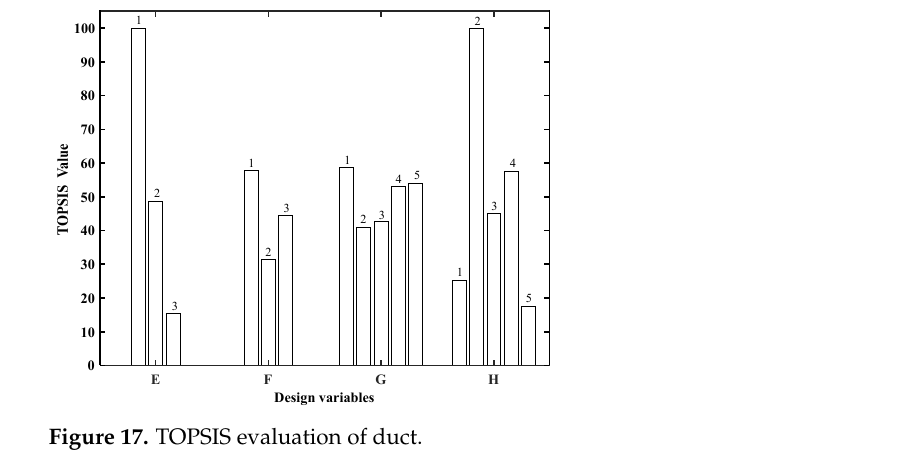
Table 10. Structural parameters of the duct.